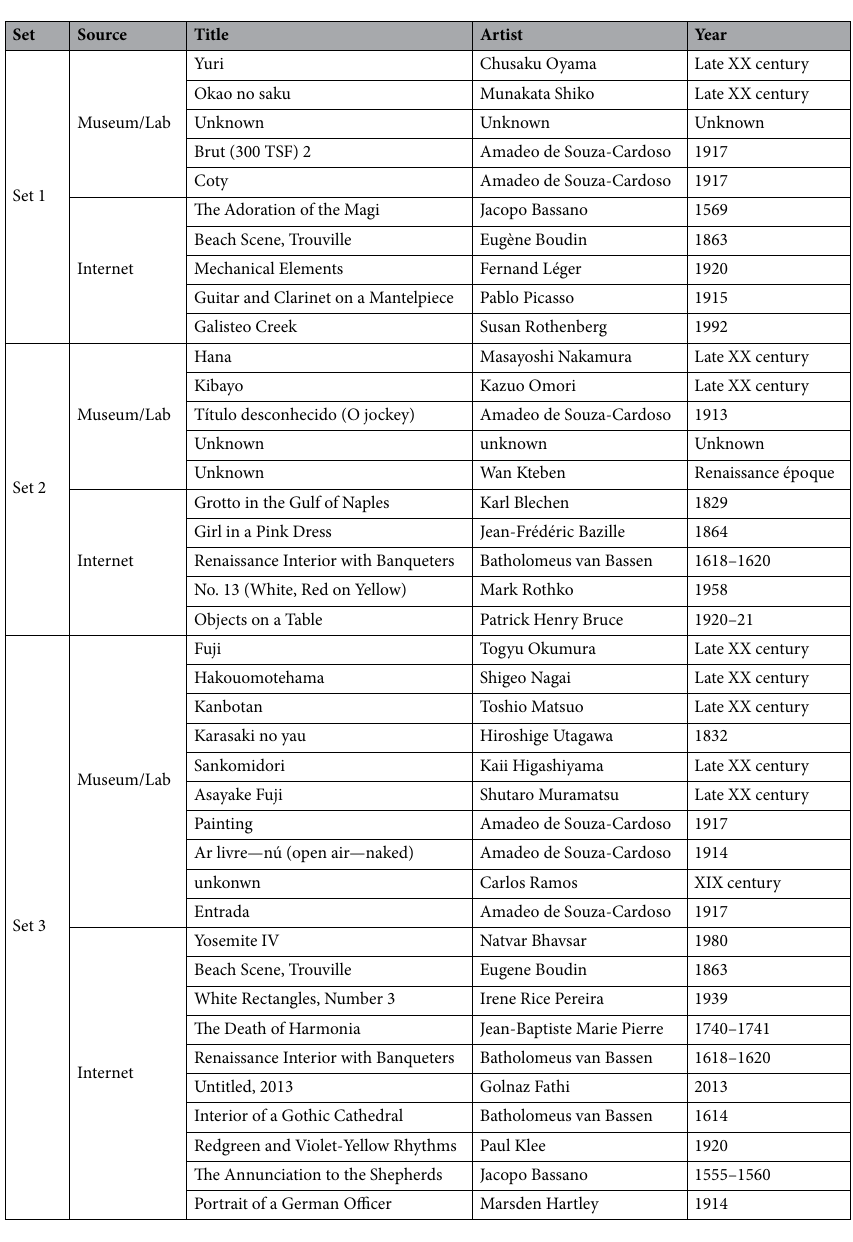
Table 1. List of paintings used in the